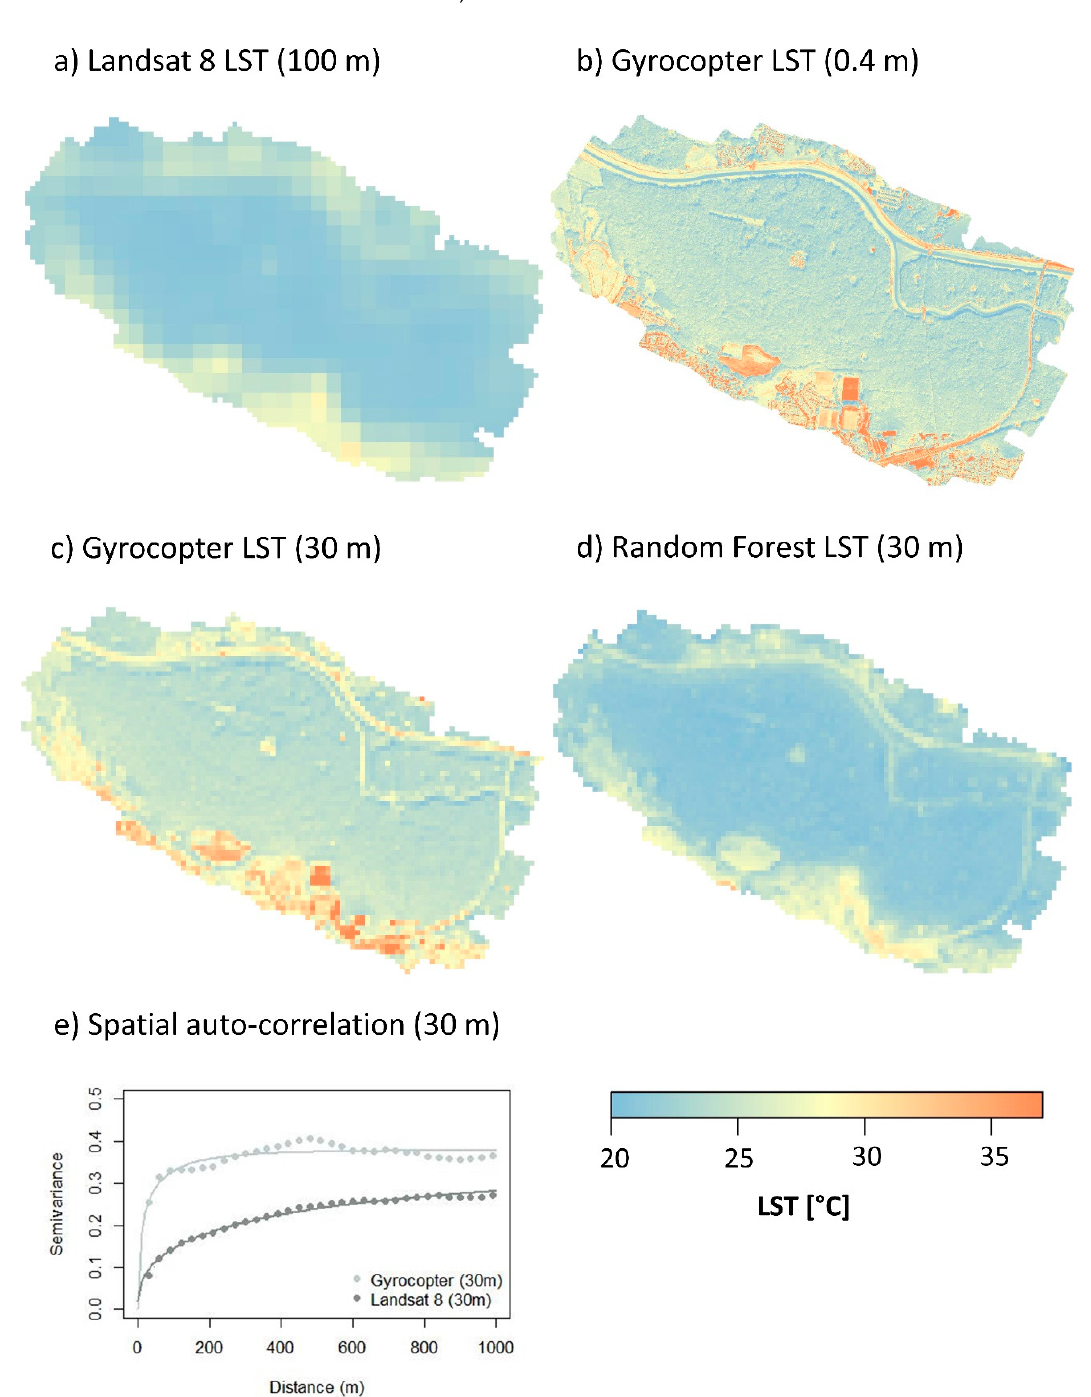
Figure 8. ( a ) Landsat 8 LST image with 100 m resolution, ( b ) gyrocopter LST image with 0.4 m resolution, ( c ) gyrocopter LST image aggregated to 30 m resolution, ( d ) Landsat 8 LST image downscaled to 30 m resolution, and ( e ) empirical semivariogram for the gyrocopter (light grey) and the Landsat 8 (dark grey) dataset at a pixel size of 30 m; semivariogram models were fitted using a powered exponential correlation structure.